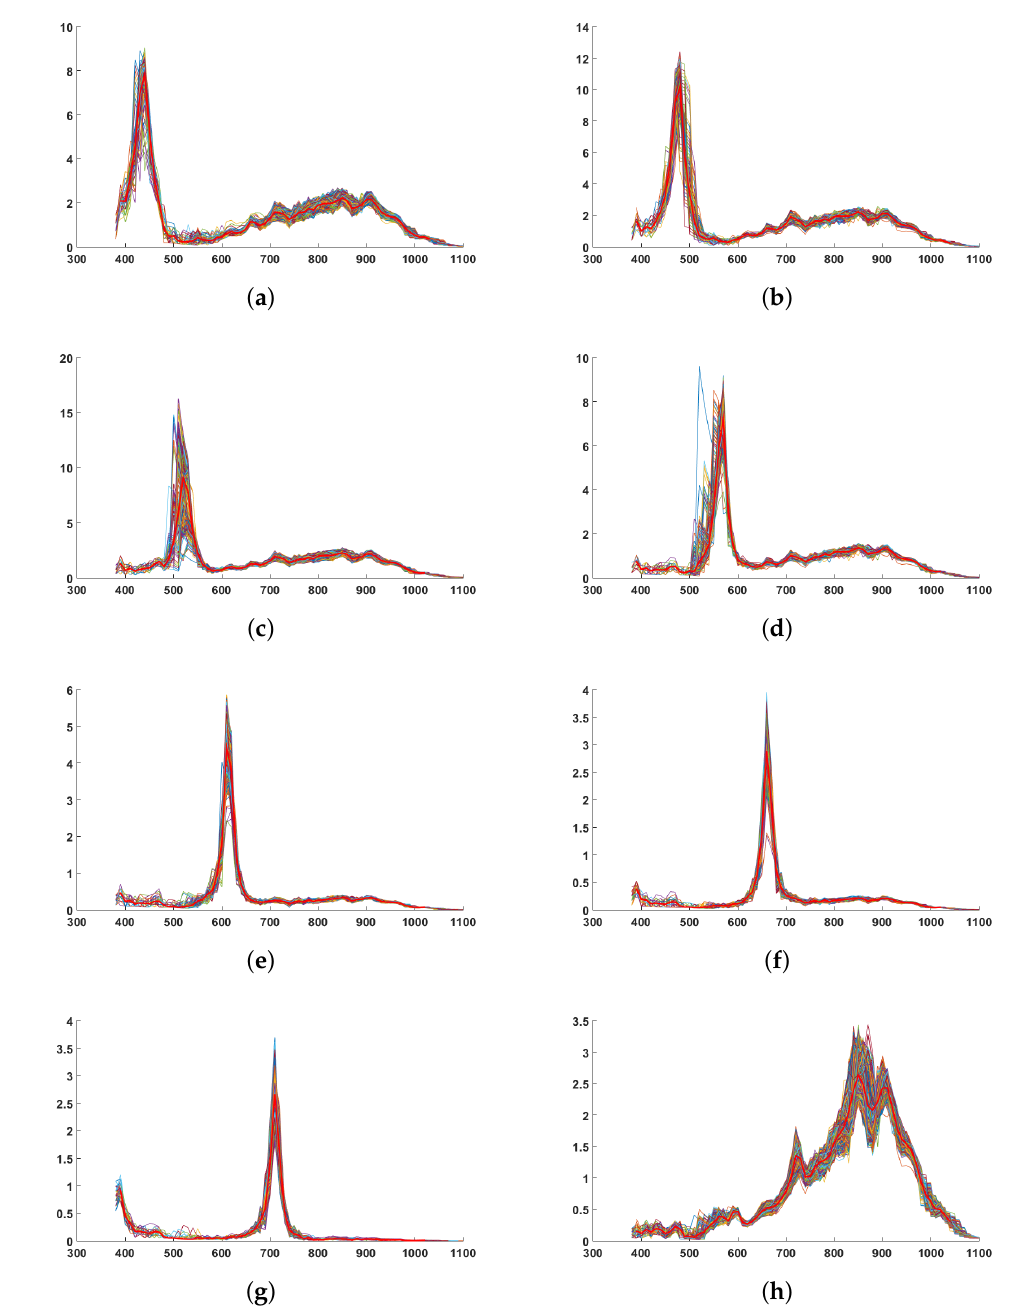
Figure 7. Spectral variation of sensor sensitivities along with the spatial dimension. In red, the average curve. Relatively to the pixel response, some of the bands have a more or less good rejection in the IR wavelengths. It seems to be directly correlated to the adjacency of the filter with the IR pixels in the moxel arrangement. ( a ) Sensitivity 1 over pixels; ( b ) Sensitivity 2 over pixels; ( c ) Sensitivity 3 over pixels; ( d ) Sensitivity 4 over pixels; ( e ) Sensitivity 5 over pixels; ( f ) Sensitivity 6 over pixels; ( g ) Sensitivity 7 over pixels; ( h ) Sensitivity 8 over